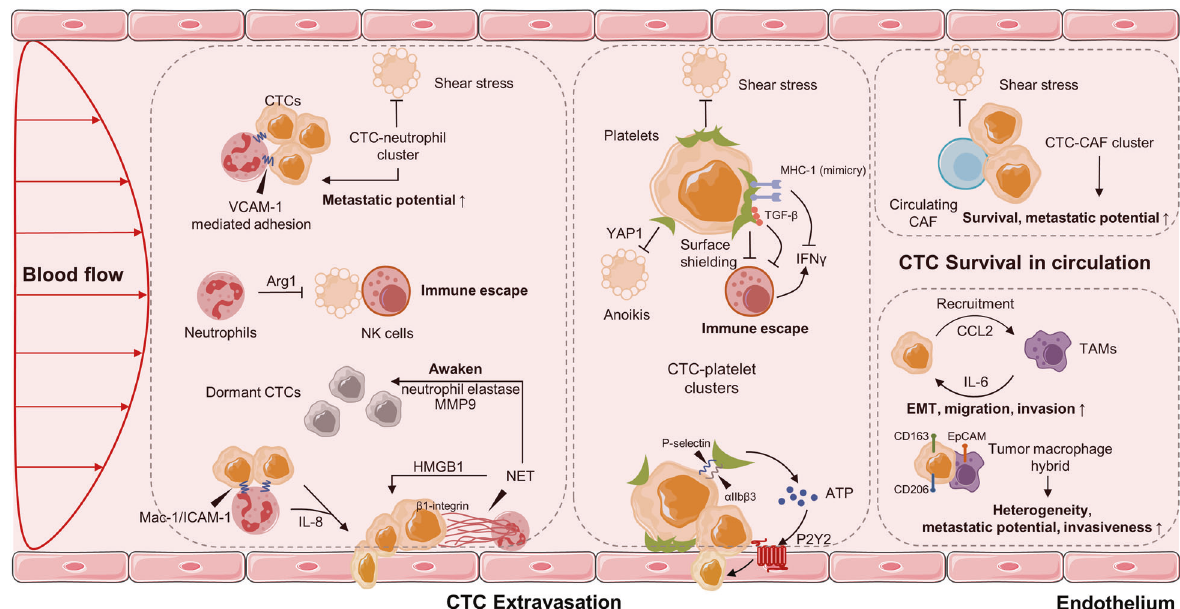
Fig. 3 CTCs in the blood microenvironment, and their interaction with neutrophils, platelets, CAFs and TAMs. CAFs: cancer-associated fi broblasts, TAMs: tumor-associated